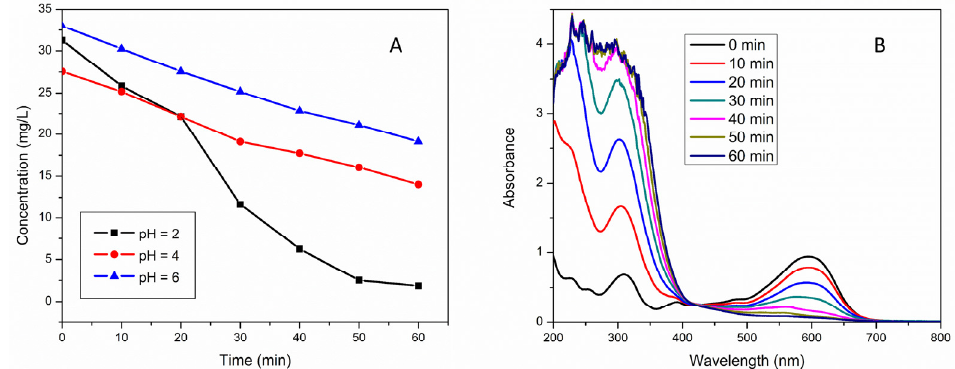
Figure 3. ( A ) RB5 removal under pH 2, 4, and 6; ( B ) UV–Vis spectra of RB5 solution in the range